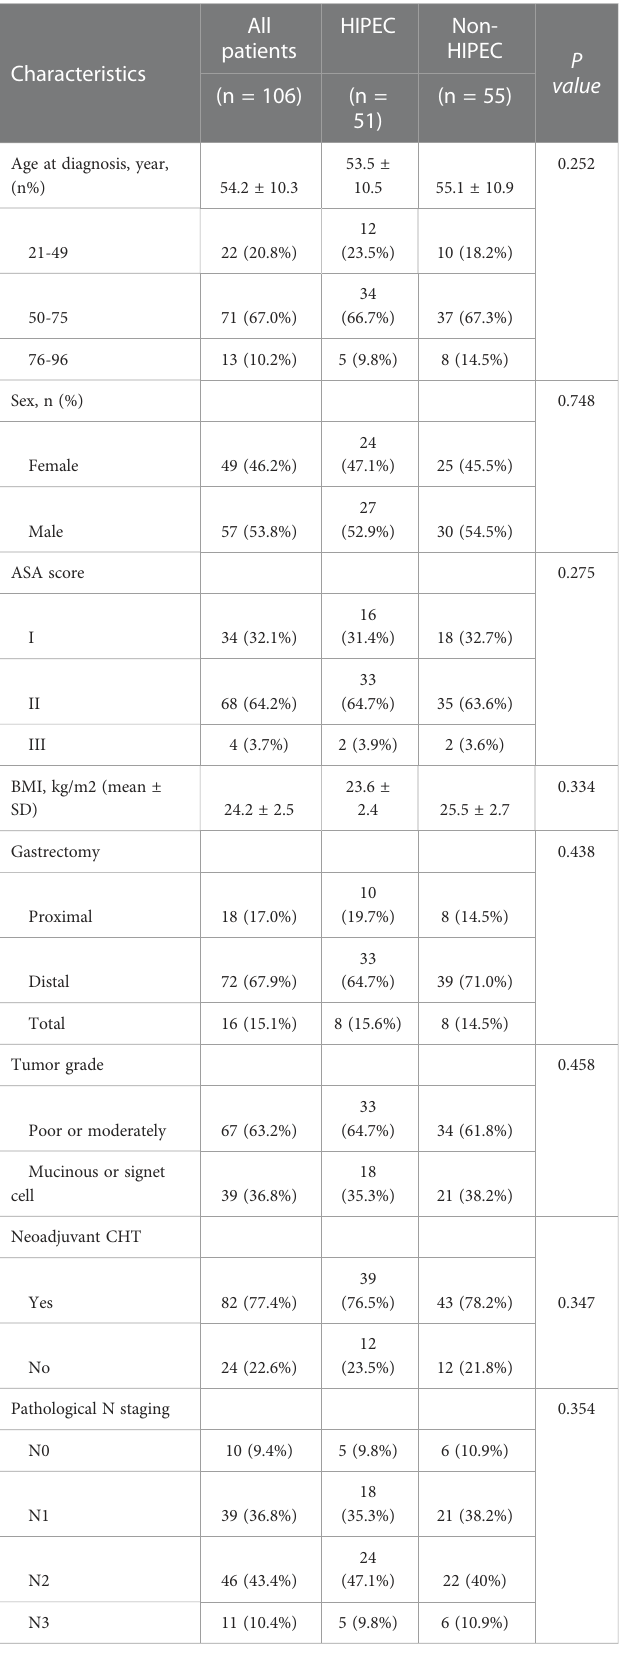
TABLE 2 Perioperative data of the